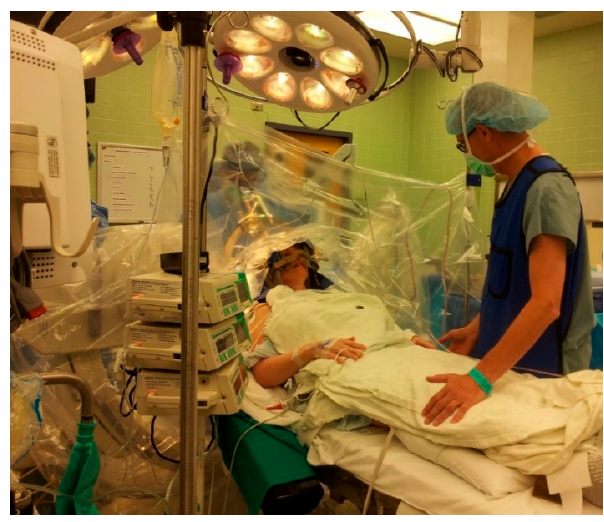
Figure 8. The final position of the patient. Note the transparent draping to allow better communication.